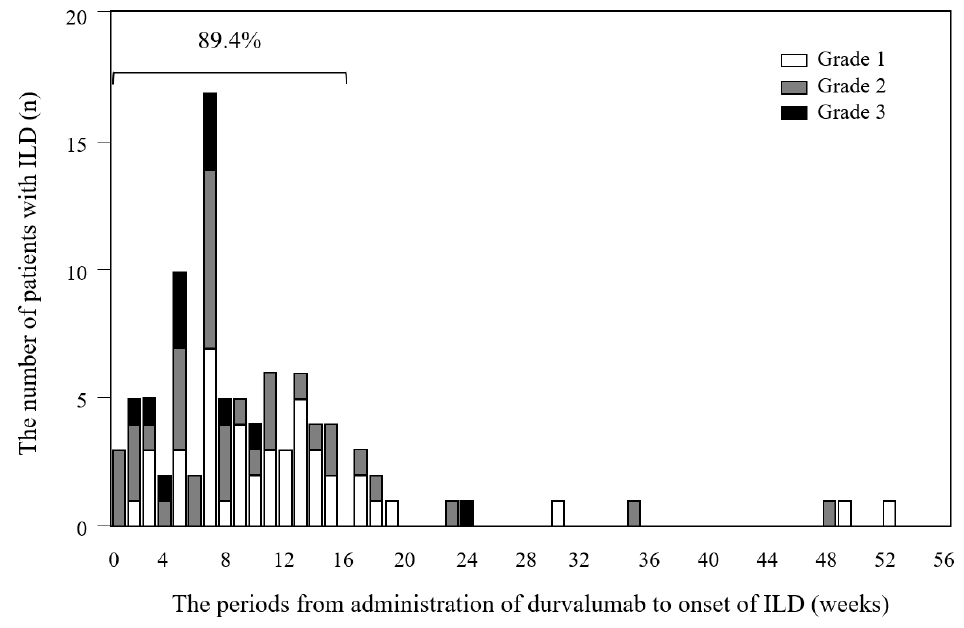
Figure 1. Onset, duration, and different grades of ILD during durvalumab treatment. ILD, interstitial lung disease. 3.3. Comparison of Characteristics between Patients with and without Grade ≥ 2 ILD